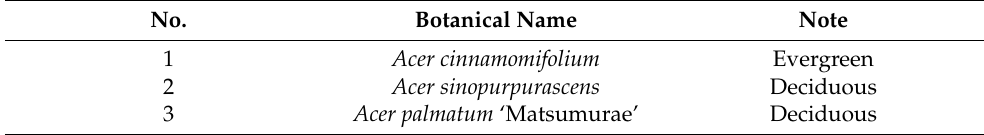
Table 1. Acer spp. information for physiological monitoring studies. No. Botanical Name Note